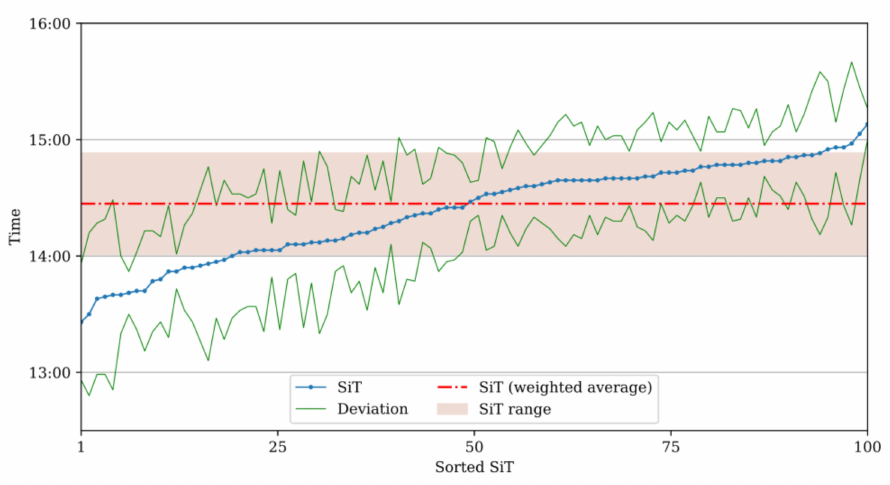
Figure 9. SiT range calculation for Node 5 (SiL) in the sample network.